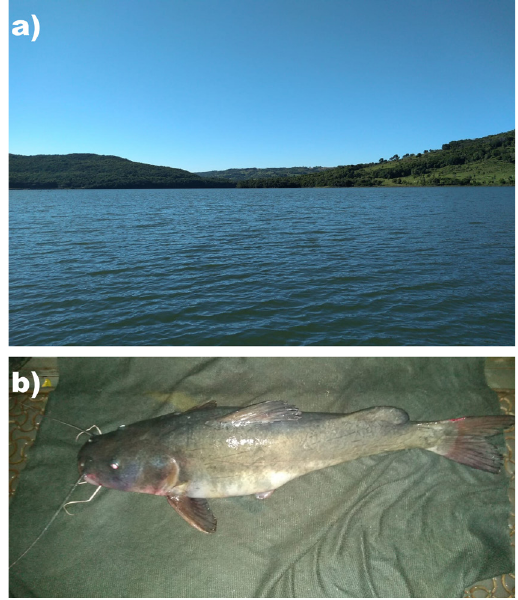
Figure 1. Photographs were taken during fieldwork showing (a) partial view of the Segredo Reservoir located in the Iguaçu River where the capture of the (b) non-native catfish “jaú” Zungaro jahu (55 cm standard length) took